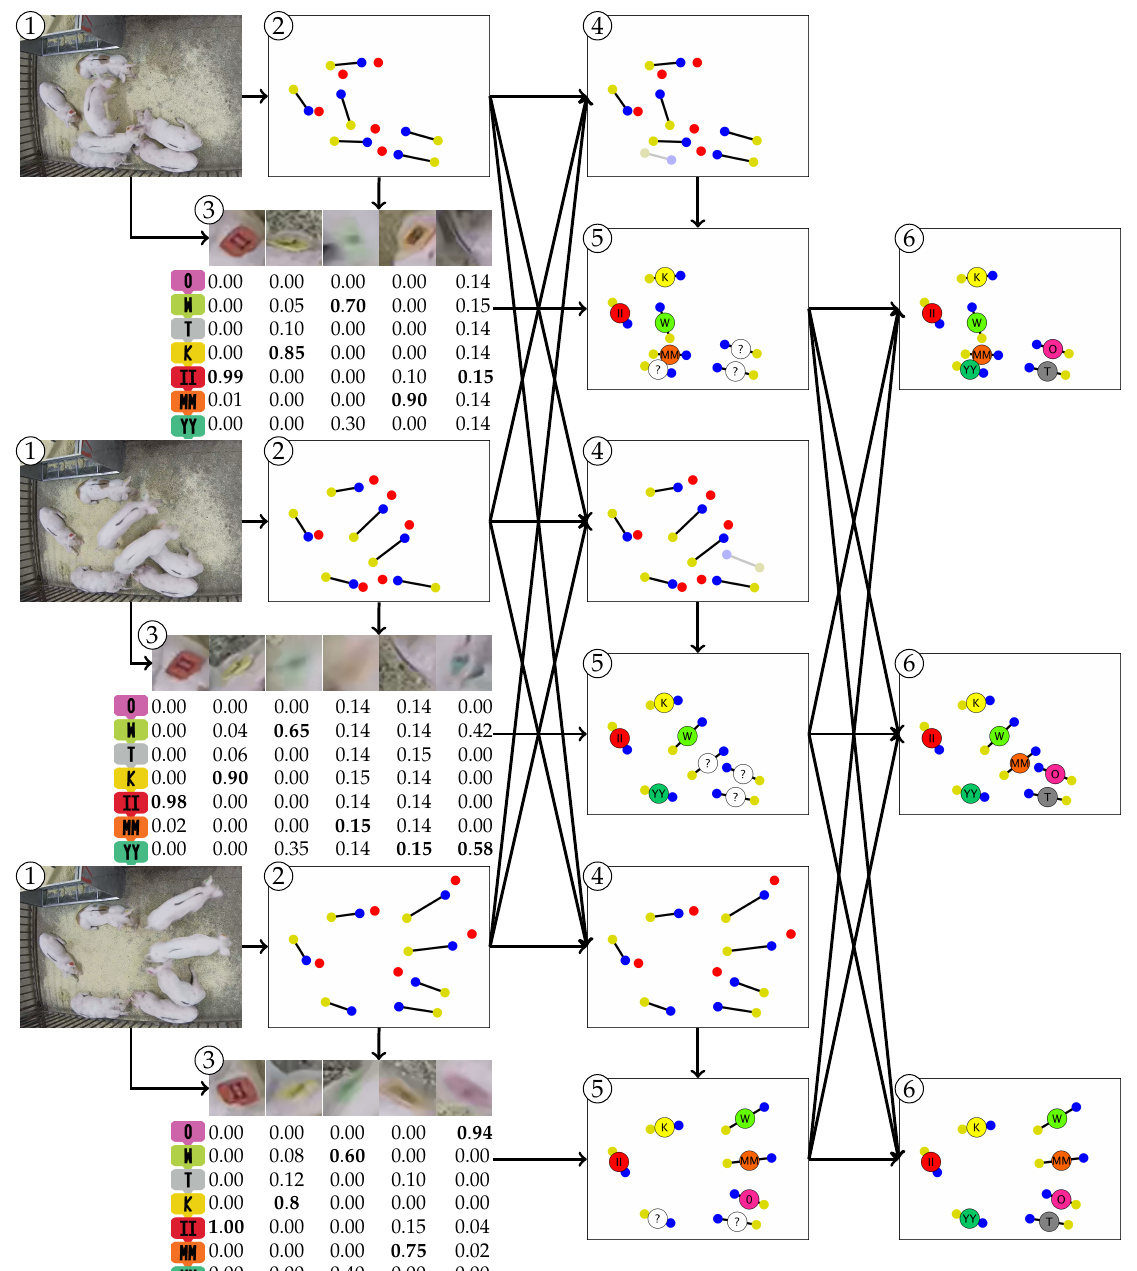
Figure 1. Three consecutive frames illustrating the six stages of processing. The input image (1) are processed using the detection method to find the locations of pigs, as defined by their matched shoulder-tail coordinates (2). Detected ear locations (2) are used to extract small image crops that can be used for ear tag classification (3). Here, there are seven possible ear tag IDs and each cropped image is mapped to a probability vector (3). The original detections (2) across all frames are used to interpolate missing detections (4). The ear tag probability vectors are mapped to all detections to initialize the ID probabilities prior to inference (5). Finally, ear tag ID probabilities are shared across frames using forward-backward MAP estimation to derive consistent